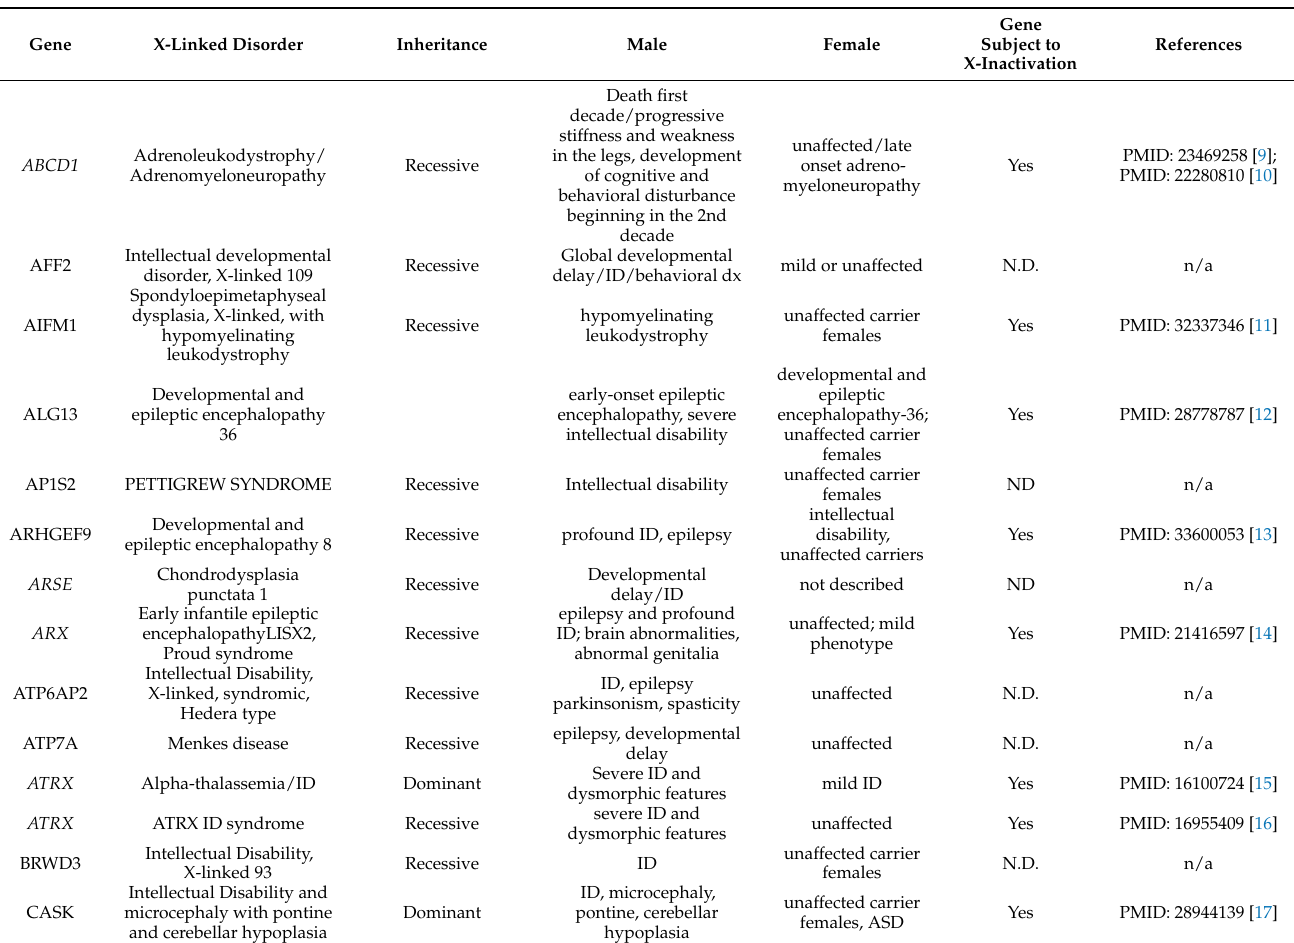
Table 1. Impact of XCI on